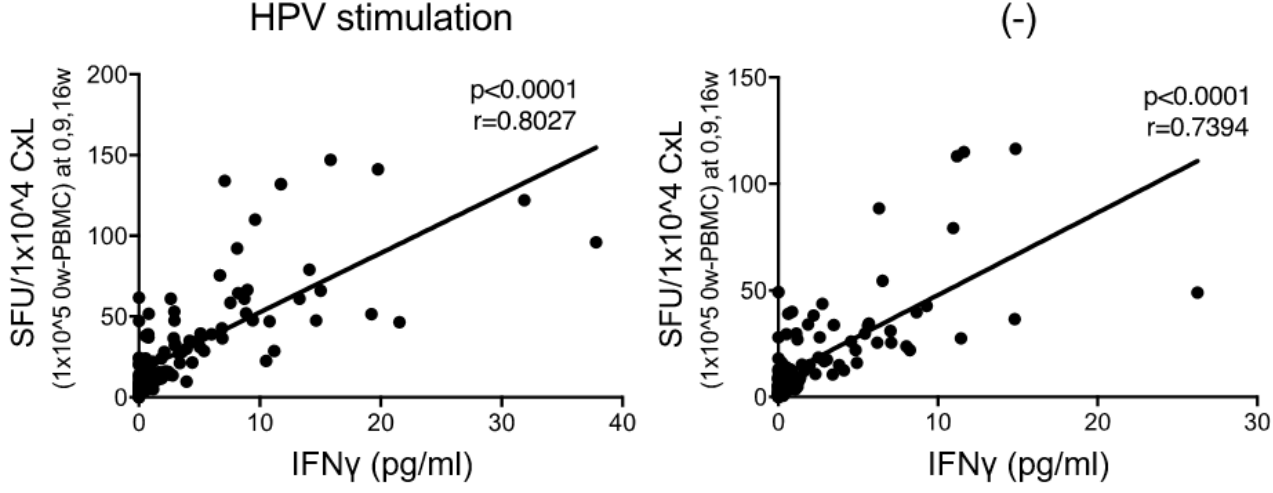
Figure 1. Correlation between the number of spots on ELISpot and IFN γ production for E7-specific Th1 response in CxL. To confirm the Th1 feature of the CxL, the number of spots on ELISpot was plotted on the Y-axis and the amount of IFN γ (pg/mL) on the X-axis, and the correlation was examined. Regardless of lymphocytes with or without E7 stimulation, a higher number of spots correlated with higher IFN γ production, indicating that ELISpot can be used to measure E7-specific Th1 immune responses in CxL.